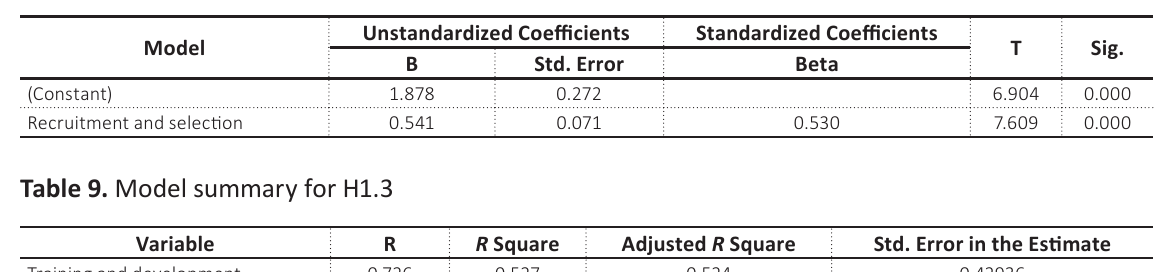
Table 8. Regression coefficients for H1.2